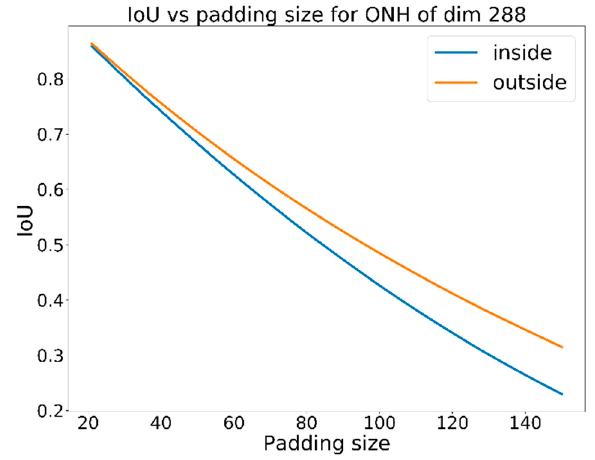
Figure 4. Padding required vs. intersection over union (IoU) between bounding boxes for images with ONH of diameter 401 pixels.